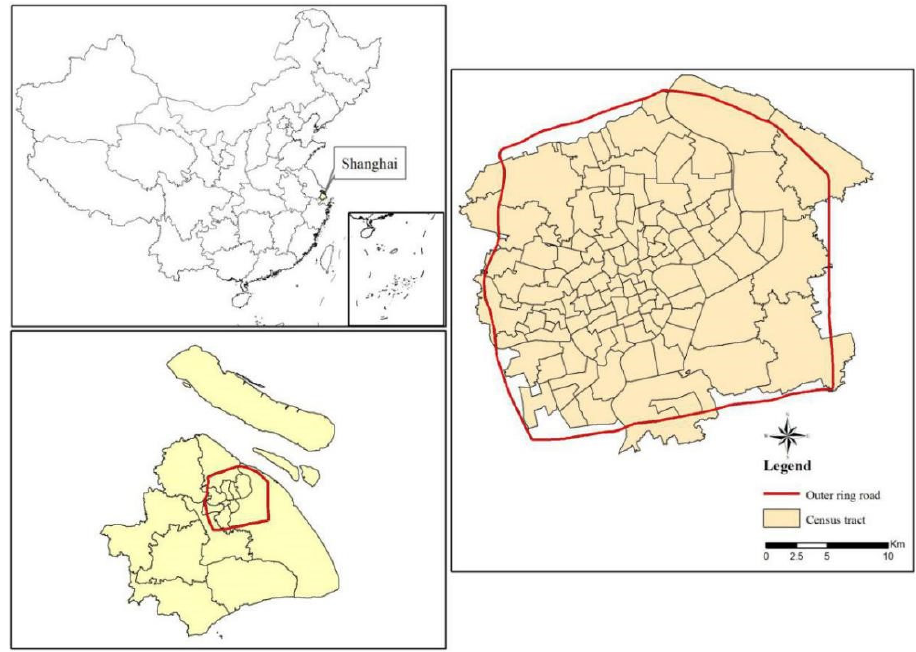
Figure 1. Location of the study area and spatial distribution of the selected census tracts.